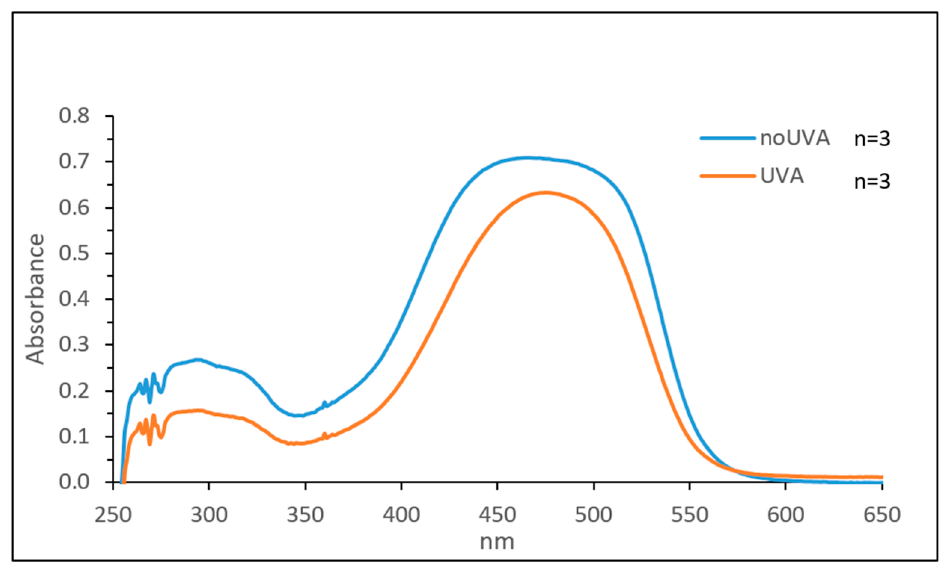
Figure 11. UV-absorption spectra of AST-SSLN before and after exposure to 275 kJ/m 2 UVA.